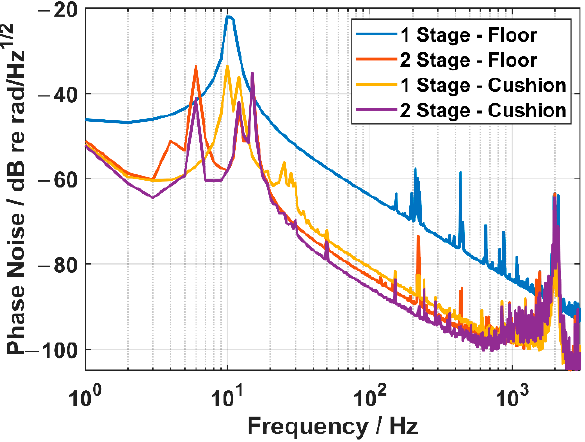
Figure 17. The phase noise of the Z channel of the FOVH in different suspension systems.